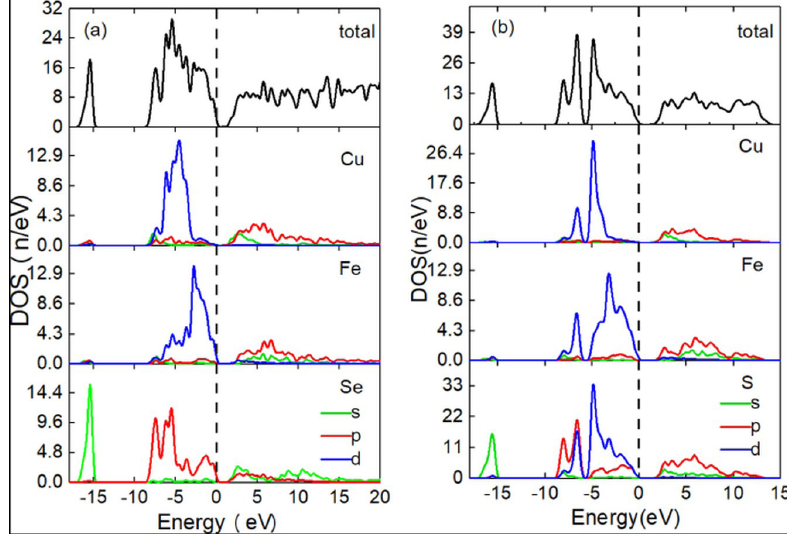
, (b) Fractional density of states of CuFeS 2